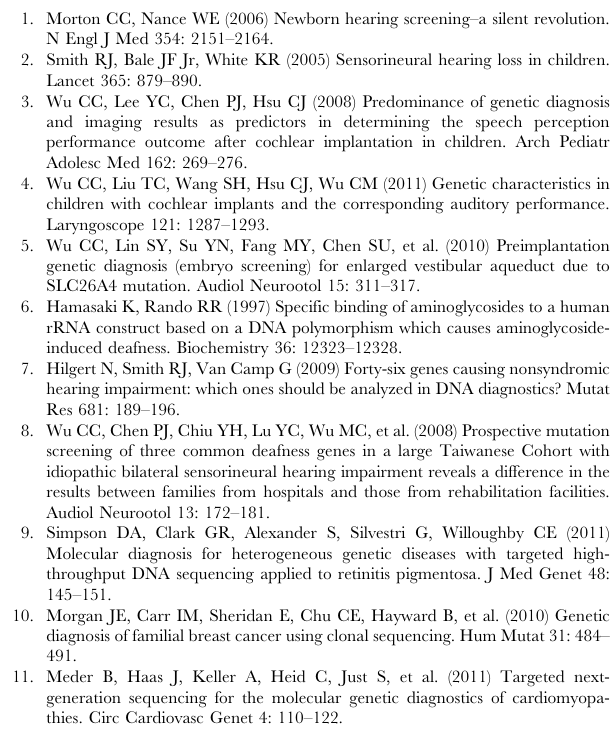
Figure S1 The pedigrees of the 12 multiplex families recruited in the present study. Families compatible with autosomal dominant inheritance and autosomal recessive inher- itance are marked with AD and AR, respectively. Arrows indicate the probands. Table S1 The 80 known human deafness genes included in